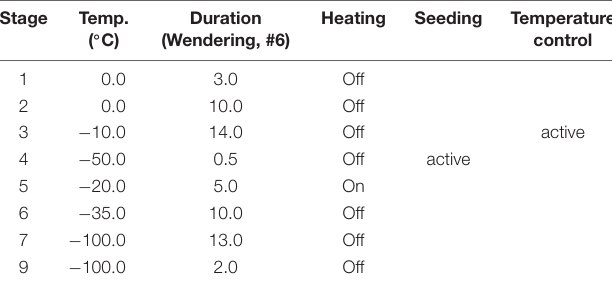
TABLE 2 | Temperature ramps underlying the programmed freezing